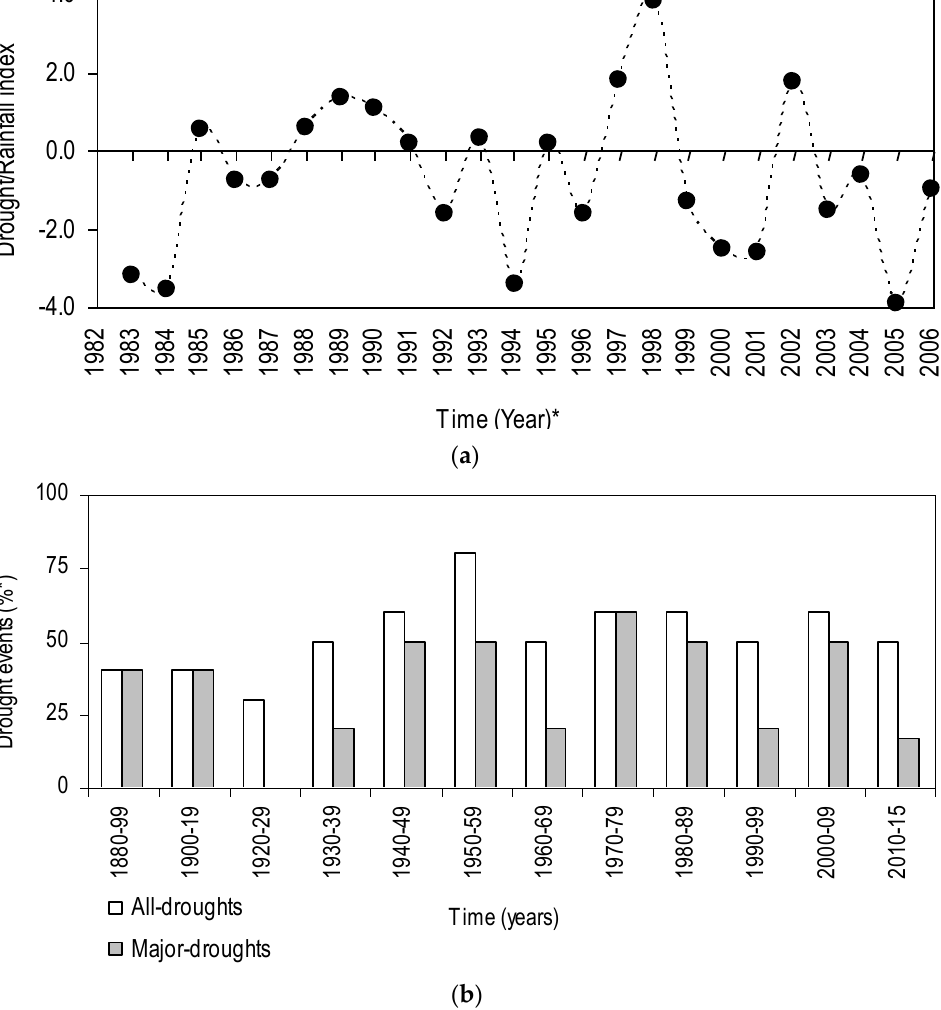
poor/failed rains ( 56%, N = 176, p < 0.01 ) or poor/failed seasonal rains ( 28%, N = 176, p < 0.05 ); source contrast (non-scholarly > scholarly): p <